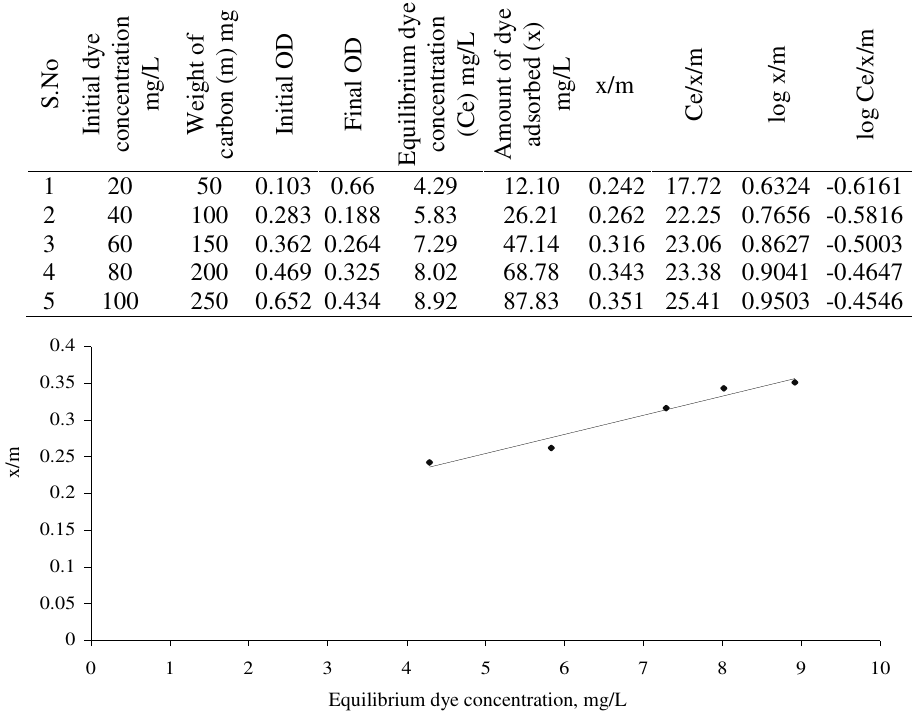
Table 4. Adsorption isotherm data (carbon size: 400 micron; contact time: 120 min)